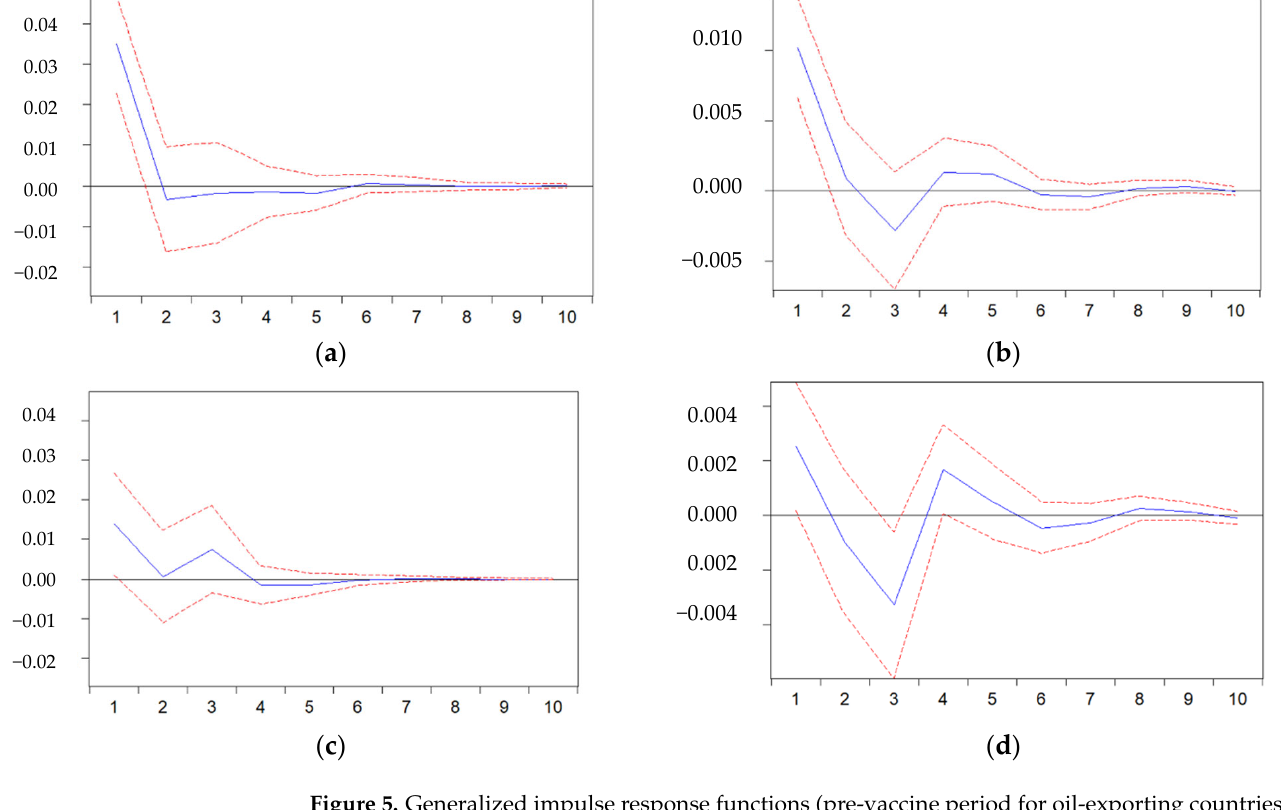
Figure 5. Generalized impulse response functions (pre ‐ vaccine period for oil ‐ exporting countries). ( a ) Response of oil to the RTS index. It is shown that when the RTS index price is shocked by one standard deviation shock, oil prices positively respond 1 day after the shock. ( b ) Response of the RTS index to oil. It is shown that when the OBX index price is shocked by one standard deviation shock, oil prices positively respond 1 day after the shock. ( c ) Response of the OBX index to oil. It is shown that when the oil price is shocked by one standard deviation shock, the RTS index price positively responds 1 day after the shock. ( d ) Response of the OBX index to oil. It is shown that when the oil price is shocked by one standard deviation shock, the OBX index price positively, negatively, and positively responds 1, 3, and 4 days, respectively, after the shocks.